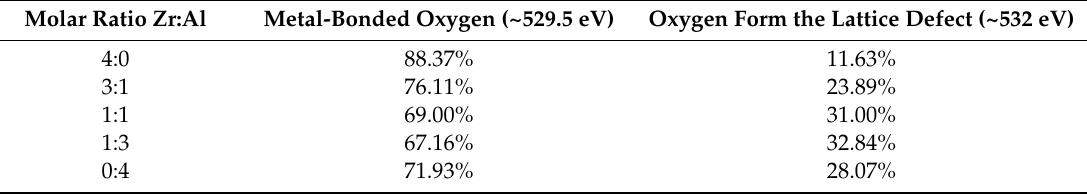
Table 2. The relative quantity of oxygen vacancies varied with the